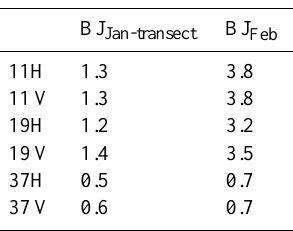
Table 8. T B sensitivity ( (cid:49)T B ) (K) associated with the small-scale variability of soil roughness ( σ